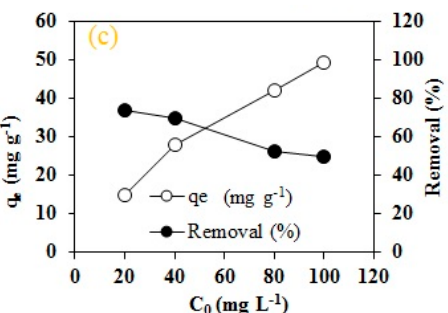
Figure 6. Effect of batch process variables on adsorption of RO16 by MA-AC400: ( a ) contact time; ( b ) adsorbent dose; ( c ) initial concentration of dye.